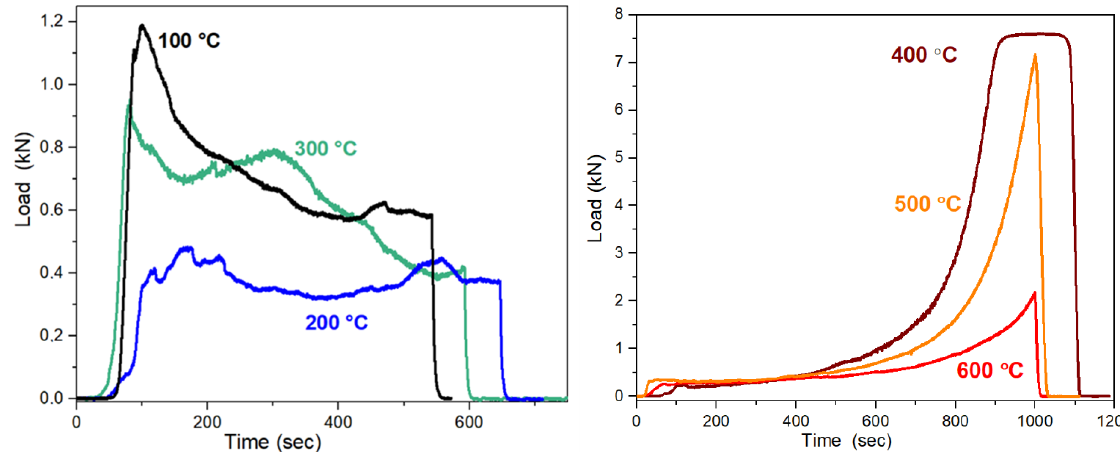
Figure 10. The load vs. time curves of the MTS compressive strength measurement of the red mud-containing composite heated at 100–300 °C and 400–600 °C. Table 1. The parameter of yield point and calculated hardness of the composites measured as a function of heat